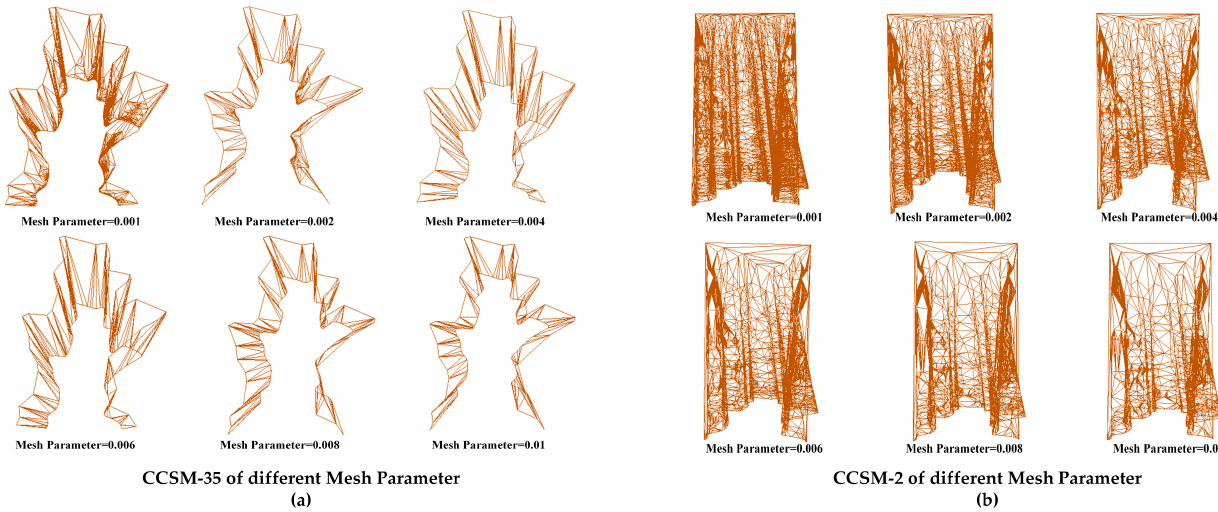
Figure 13. CCS-35 and CCS-2 under different mesh parameters. ( a ) CCS-35. ( b ) CCS-2. We obtained 100 simplified contours by intersecting 100 horizontal planes with